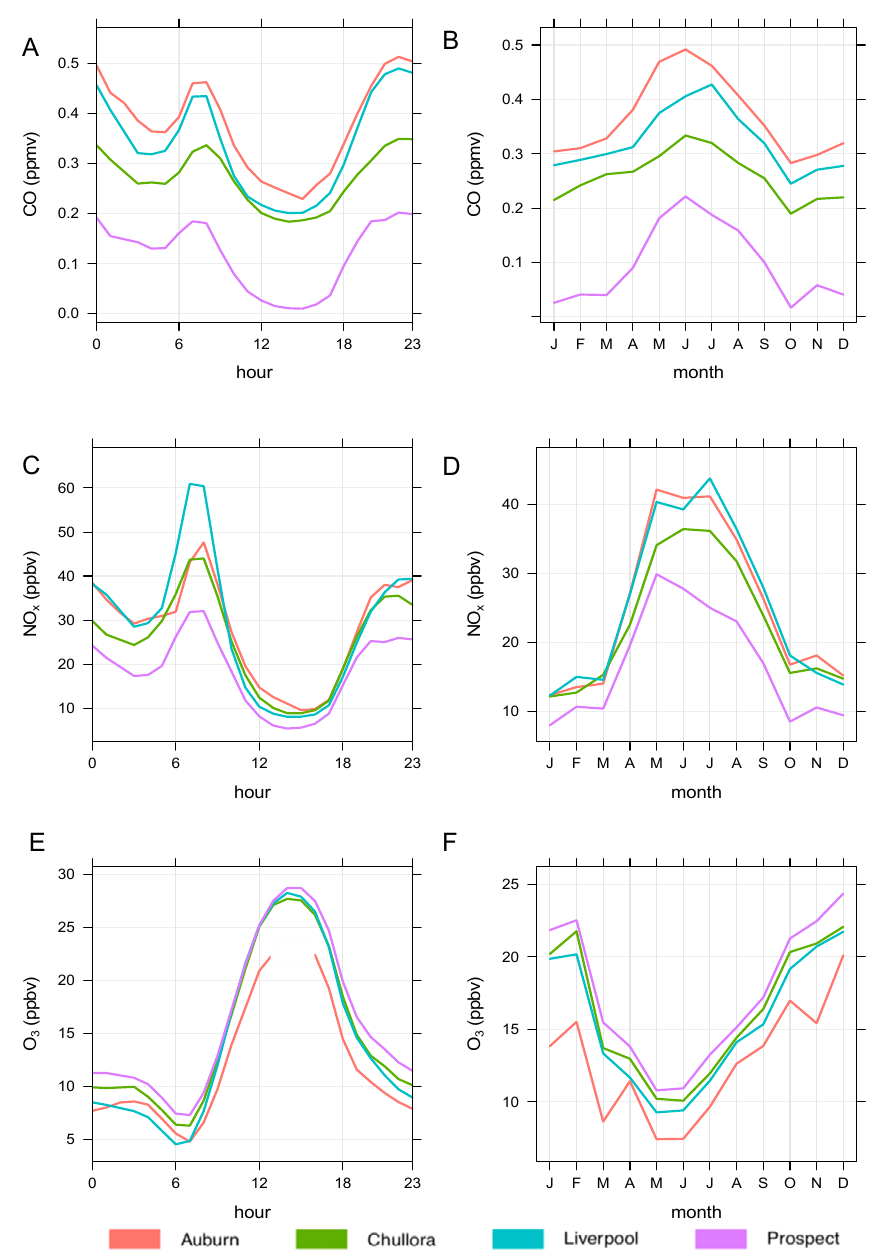
Figure 4. Diurnal and seasonal cycles of mean carbon monoxide mole fractions (( A , B ), respectively), oxides of nitrogen (( C , D ), respectively), and ozone (( E , F ), respectively) at the Auburn balcony site and three surrounding air quality monitoring stations. Calibration of the ozone monitor occurred at 13:00–14:00 daily, and hence measurements have been